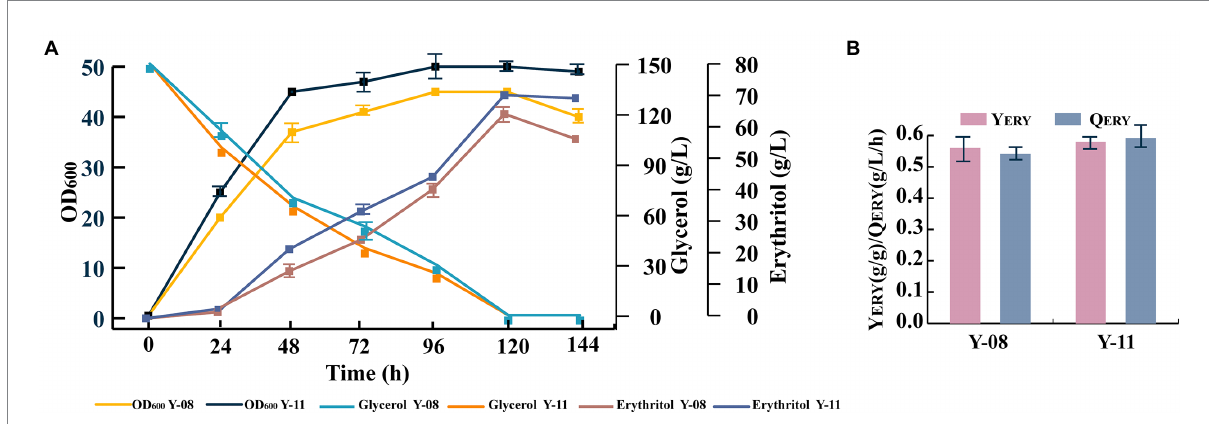
FIGURE 5 The EYD1 gene encoding erythritol dehydrogenase was disrupted in strain Y-11. (A) OD 600 , crude glycerol utilization and erythritol titers of engineered strains Y-08 and Y-11. (B) Erythritol yield and productivity of engineered strains Y-08 and Y-11. Three biological replicates were used to obtain the data. The error bars represented the standard